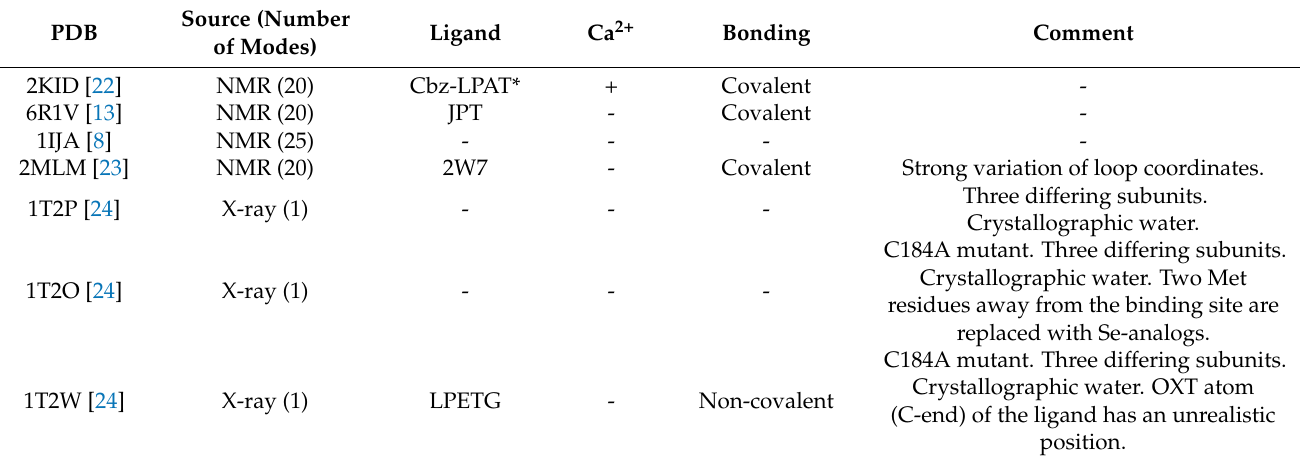
Table 1. The experimentally determined S. aureus SrtA geometries from the PDB.